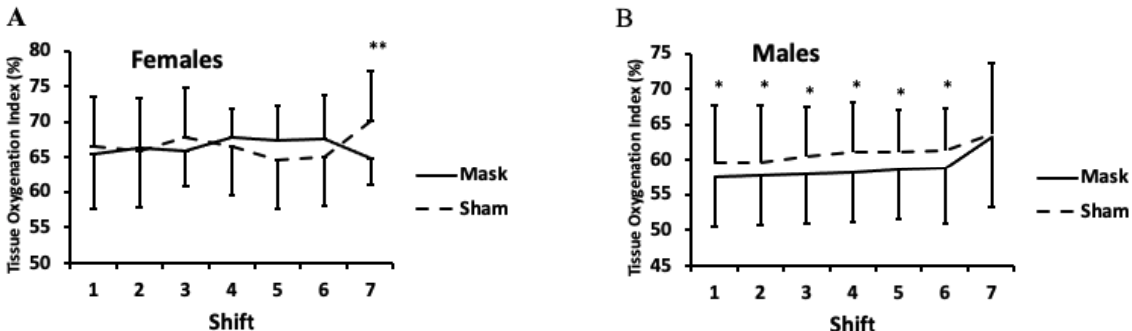
Figure 7. Arterial oxygen saturation during each simulated hockey shift. There were no differences between mask and sham conditions. There was a time main effect ( p < 0.01) with oxygen saturation lower after the seventh shift (i.e., the repeated Wingate tests) compared to all other shifts. Values are means and error bars are SD.